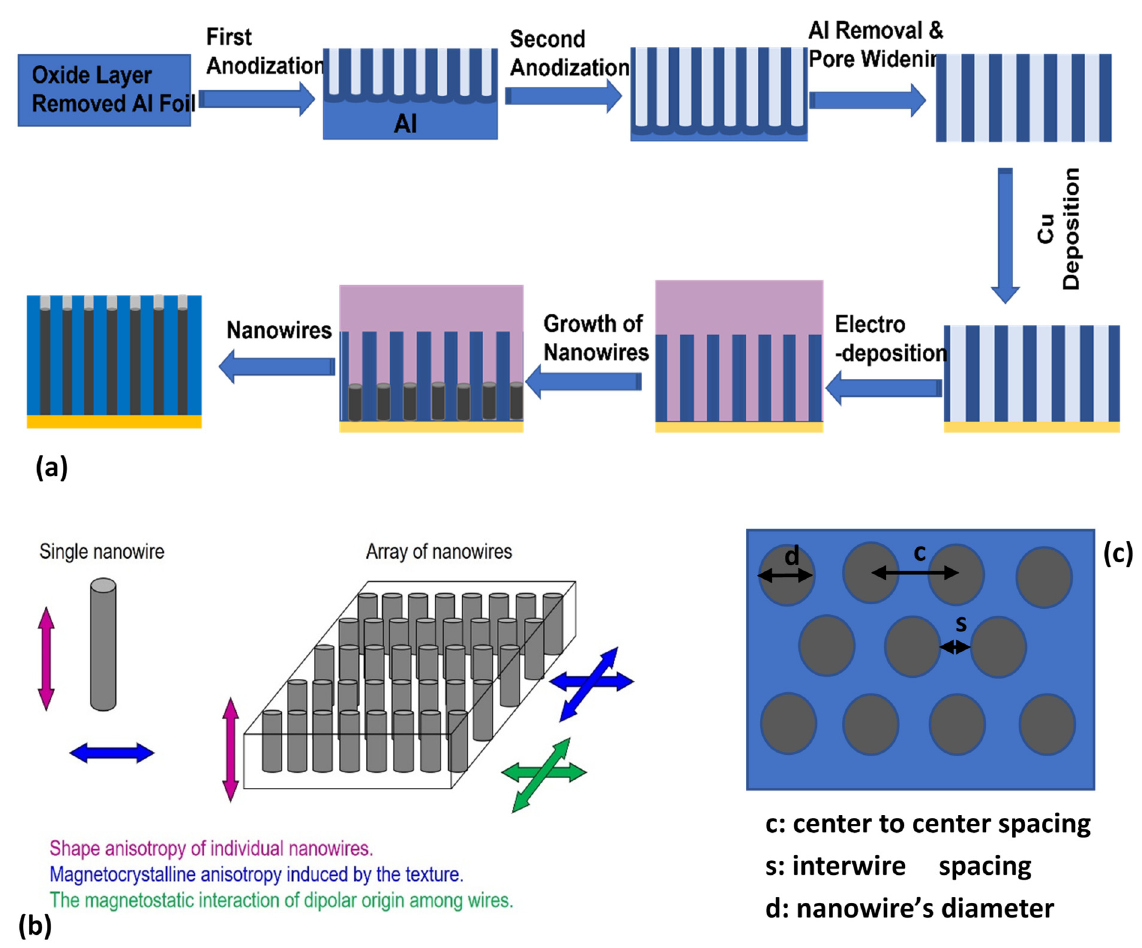
Figure 1. ( a ) A schematic illustration of sample preparation in this study, ( b ) energy contribution to magnetic behavior in nanowires’ array, and ( c ) spacing and diameter symbols used in the text are illustrated in ‘c’.